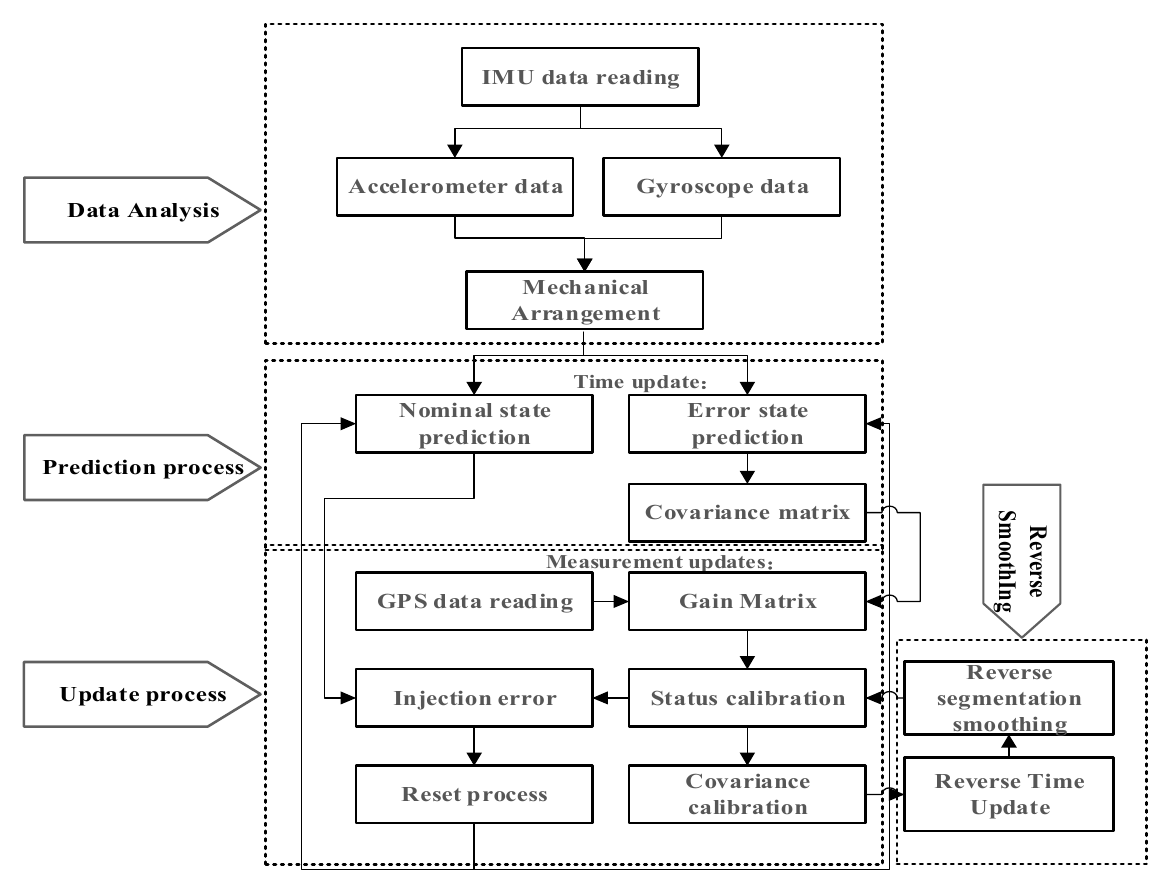
Figure 1. Flow chart of the designed ESKF − RTS algorithm.